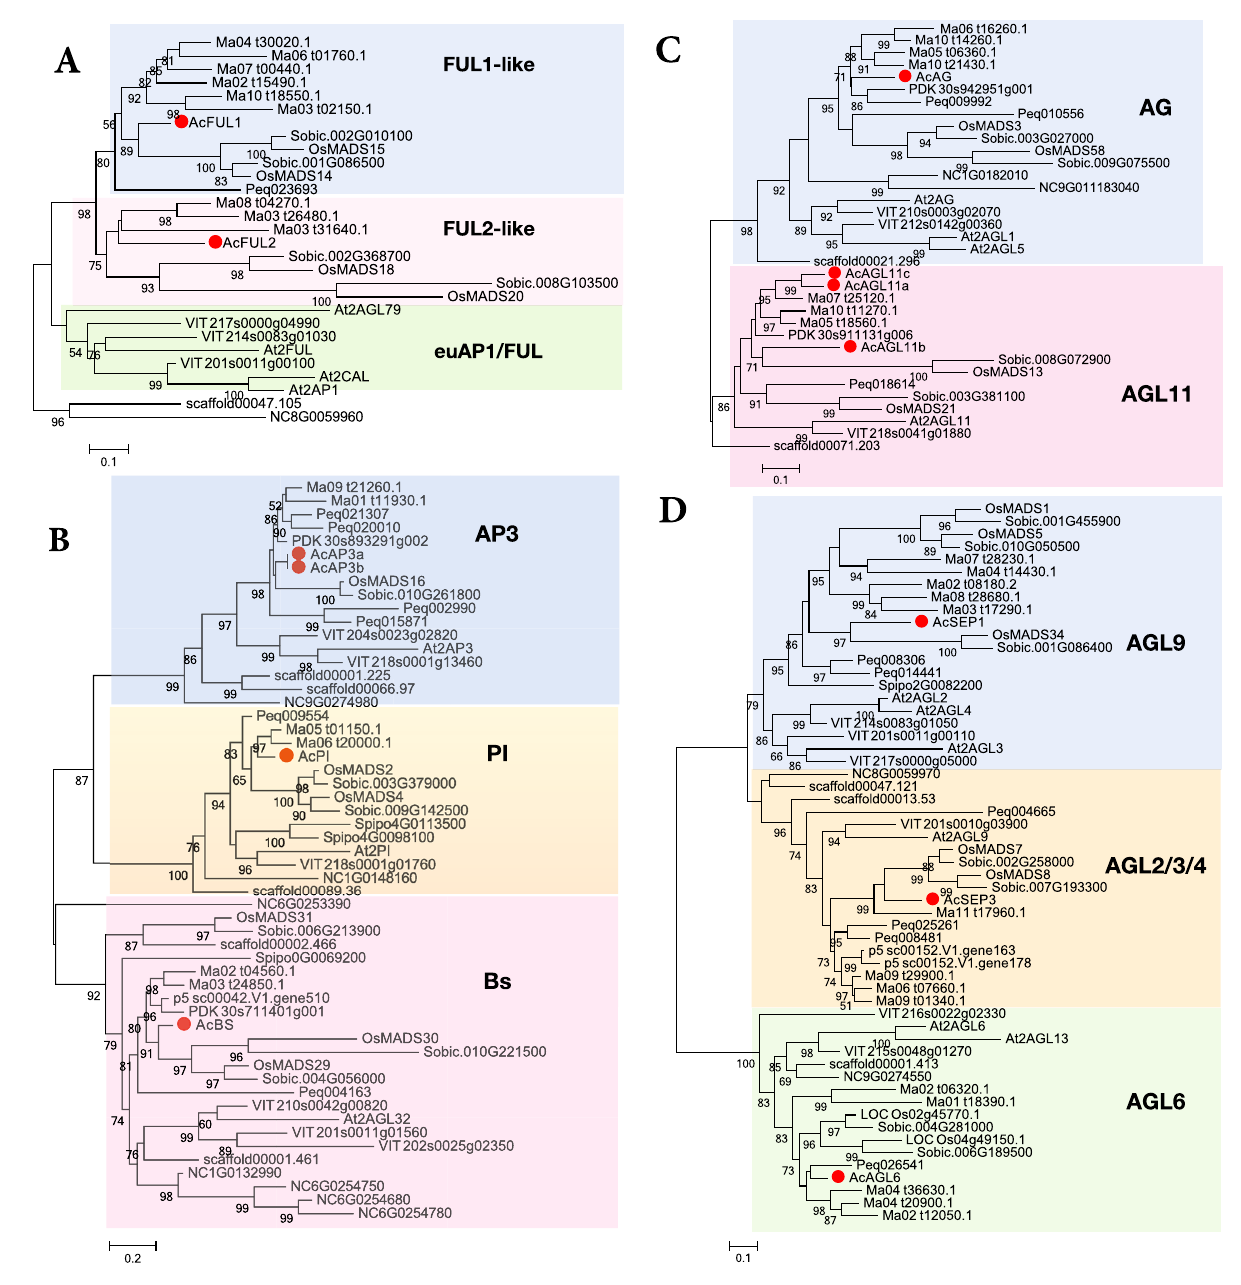
Figure 4. The ML trees of the AP1/FUL-, AP3/PI-, AG/AGL11-, and SEP/AGL6-subfamily genes. The tree was generated after multiple sequence alignment using MAFFT and the ML method. The major clades previously identified in each subfamily are indicated with different colors. The pineapple MADS-box genes are marked by red dots. The species are abbreviated as follows in the gene names: pineapple, Ac; Amborella , Scaffold; waterlily, Nc; Arabidopsis , At; rice, Loc_Os; and sorghum, major expression clusters (B1, B2, B3, and B4) were observed for all MADS-box genes after expression nor- malization and cluster analysis (Fig. 7; Supplementary Table S3). The B1 cluster included six genes, which were subdivided into two expression groups. The first group contained three genes ( AcAGL6 , AcAG , and AcPI ) that were highly expressed in three floral organs. AcSEP3 , AcSOC1a , and AcFLC1 in the second group all had abun- dant transcript levels in all whorls of floral organs, which indicated extensive involvement in the physiological processes of flower development and organogenesis. The B2 cluster contained three genes, a BS subfamily gene ( AcBS ) and two AGL11 subfamily genes ( AcAGL11a and AcAGL11c ). These were highly expressed throughout all developmental stages of only ovules. The B3 cluster had three expression groups, and the genes exhibited diverse expression profiles. The first expression group contained three genes, AcAGL11b , AcFUL1 , and AcSEP1 , which belonged to distinct MIKC subfamilies. AcAGL11b was mainly expressed in reproductive organs (stamens and pistils). AcFUL1 was mostly detected in whorls 1 and 4; AcSEP1 in whorls 1, 2, and 4. In the second group,